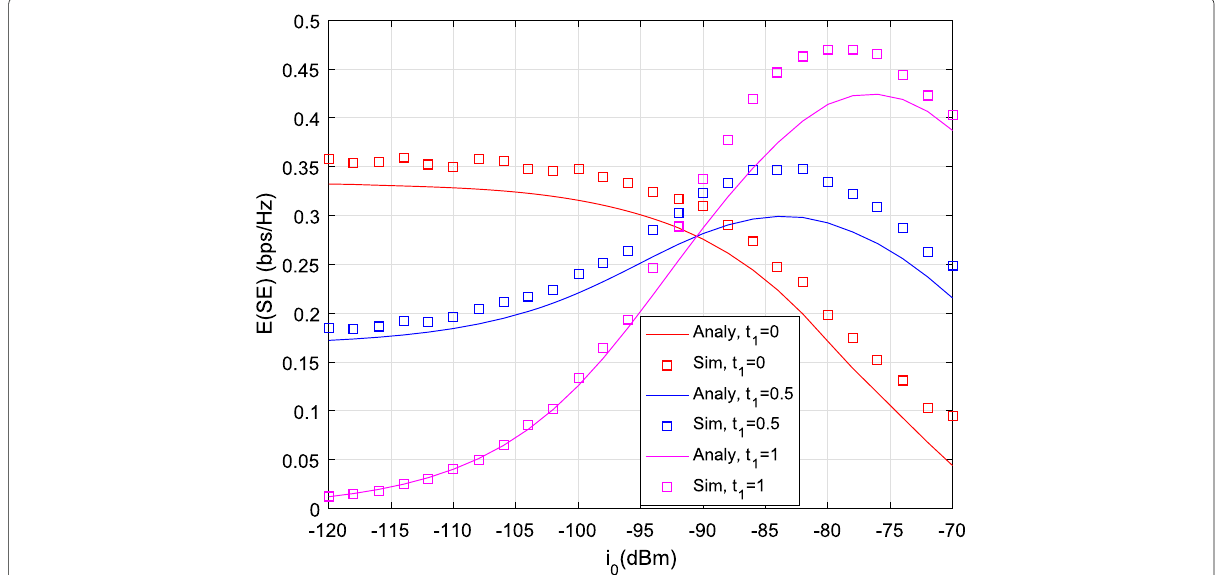
Fig. 16 Average SE as a function of i 0 for the hybrid system (AMC) with (cid:5) = 1, t ( 1 ) / t ( 2 ) = 9 dB and p max →